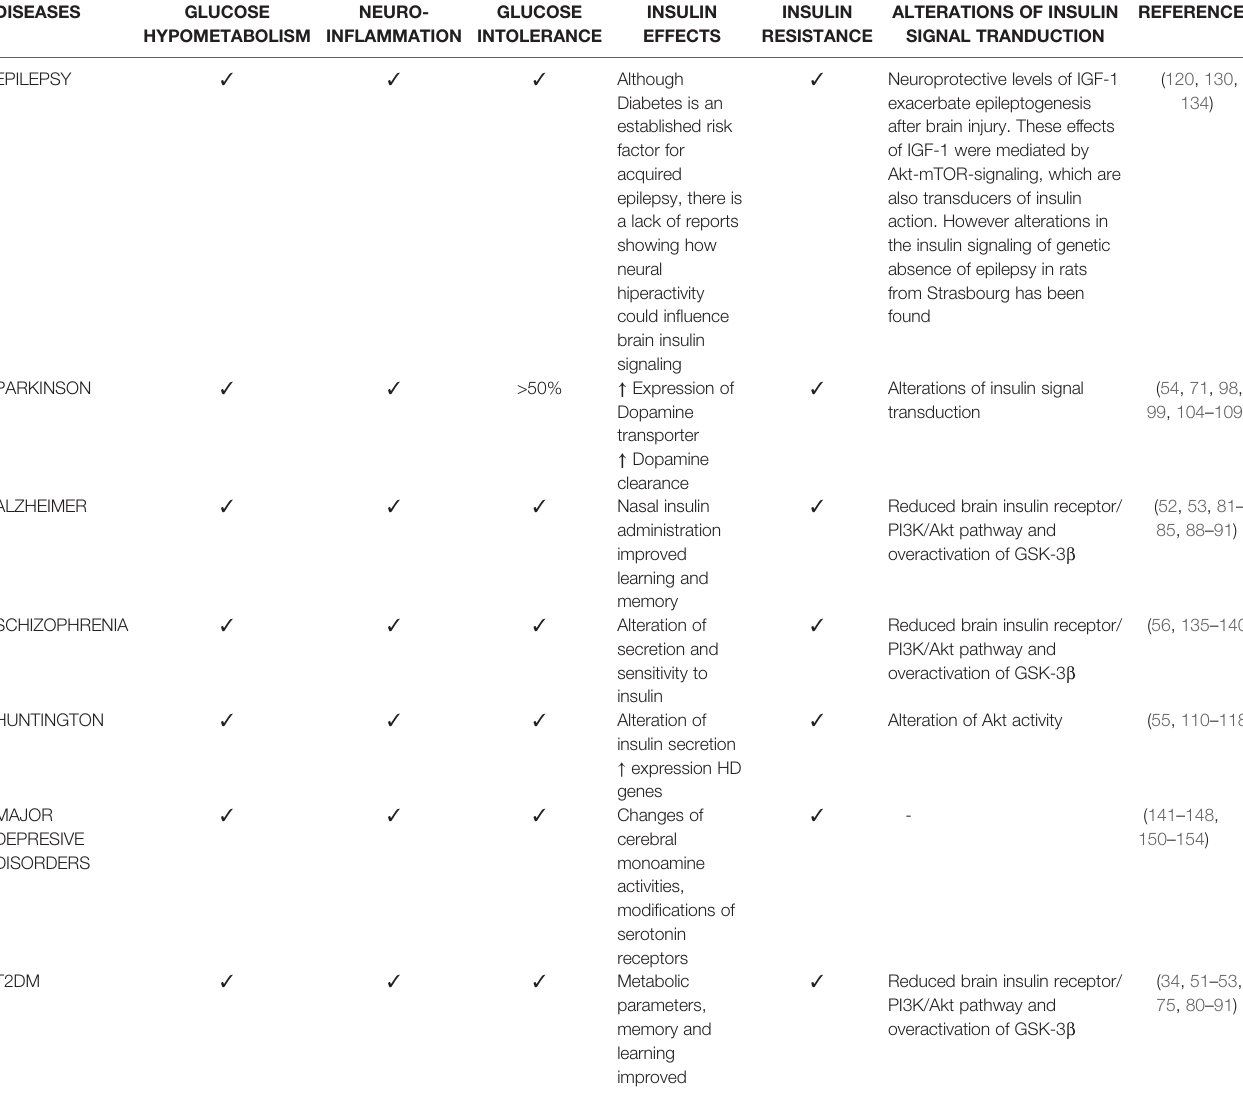
TABLE 3 | Alterations of glucose metabolism and of insulin action in brain of several neurological diseases and Type 2 Diabetes Mellitus.